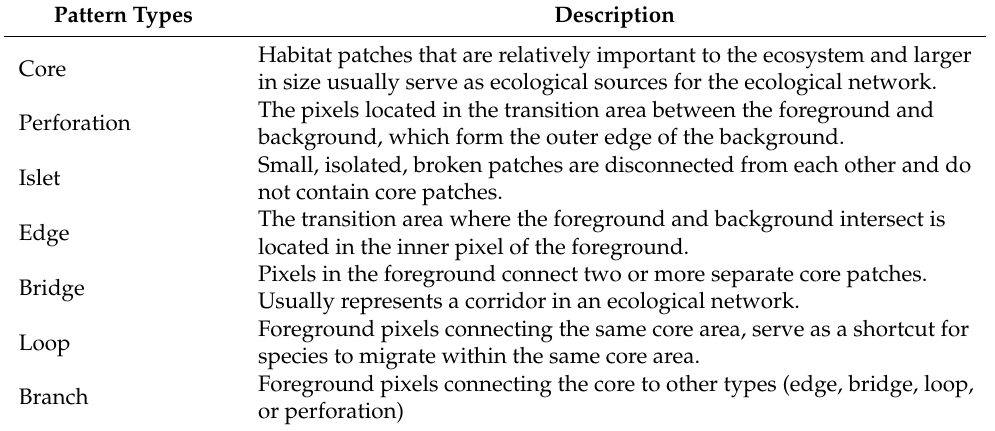
Table 2. MSPA pattern classes